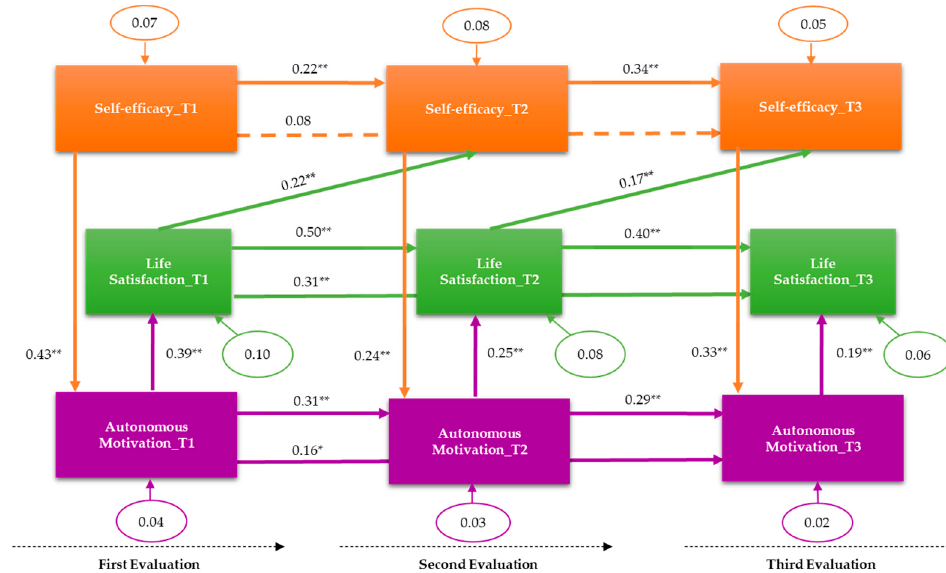
Figure 2. Predictive model of life satisfaction in CVD patients. Standardized coefficients and error terms (circles) are specified. ** p < 0.001; * p < 0.05. The pathway between self-efficacy at T1 and self-efficacy at T3 was non-significant ( p > 0.05).